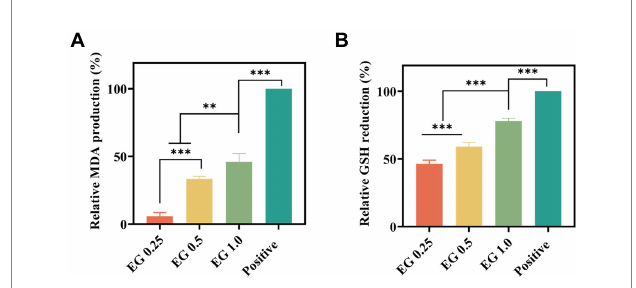
FIGURE 6 Effect of EG on the malondialdehyde (MDA) expression (A) and intracellular GSH expression (B) in the bacteria. ** p < 0.01, *** p <